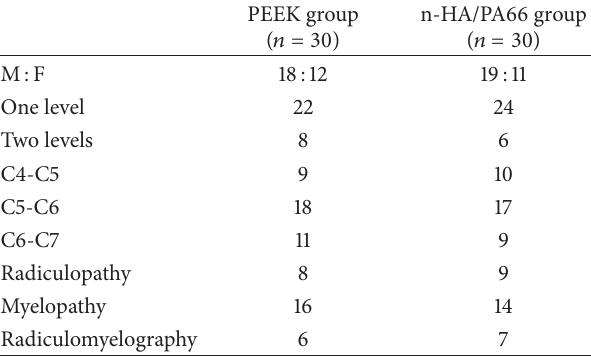
Table 1: Demographic data of cervical spondylitis.